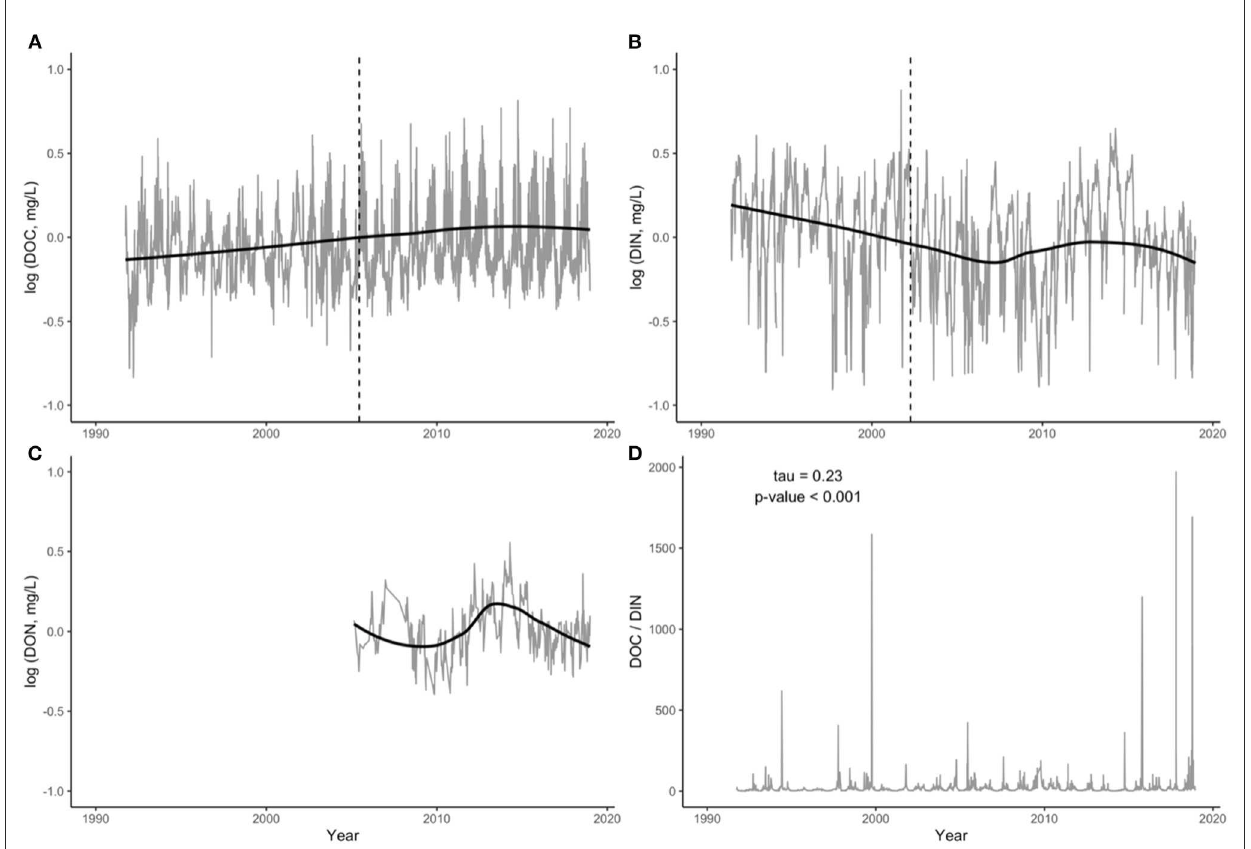
FIGURE3 Long-term trends in (A) flow-adjusted dissolved organic carbon (DOC) concentrations, (B) flow-adjusted dissolved inorganic nitrogen (DIN) concentrations, (C) flow-adjusted dissolved organic nitrogen (DON) concentrations, and (D) C:N ratios calculated from DOC and DIN concentrations. For DOC FA and DIN FA , change points (indicated by vertical dashed lines) were found in the early 2000s and trends both before and after the change points are statistically significant ( α ≤ 0.05) and positive for all, except negative for DIN before the change point. Seasonal Mann Kendall tests on C:N ratios indicate a positive trend (tau = 0.23) over the time